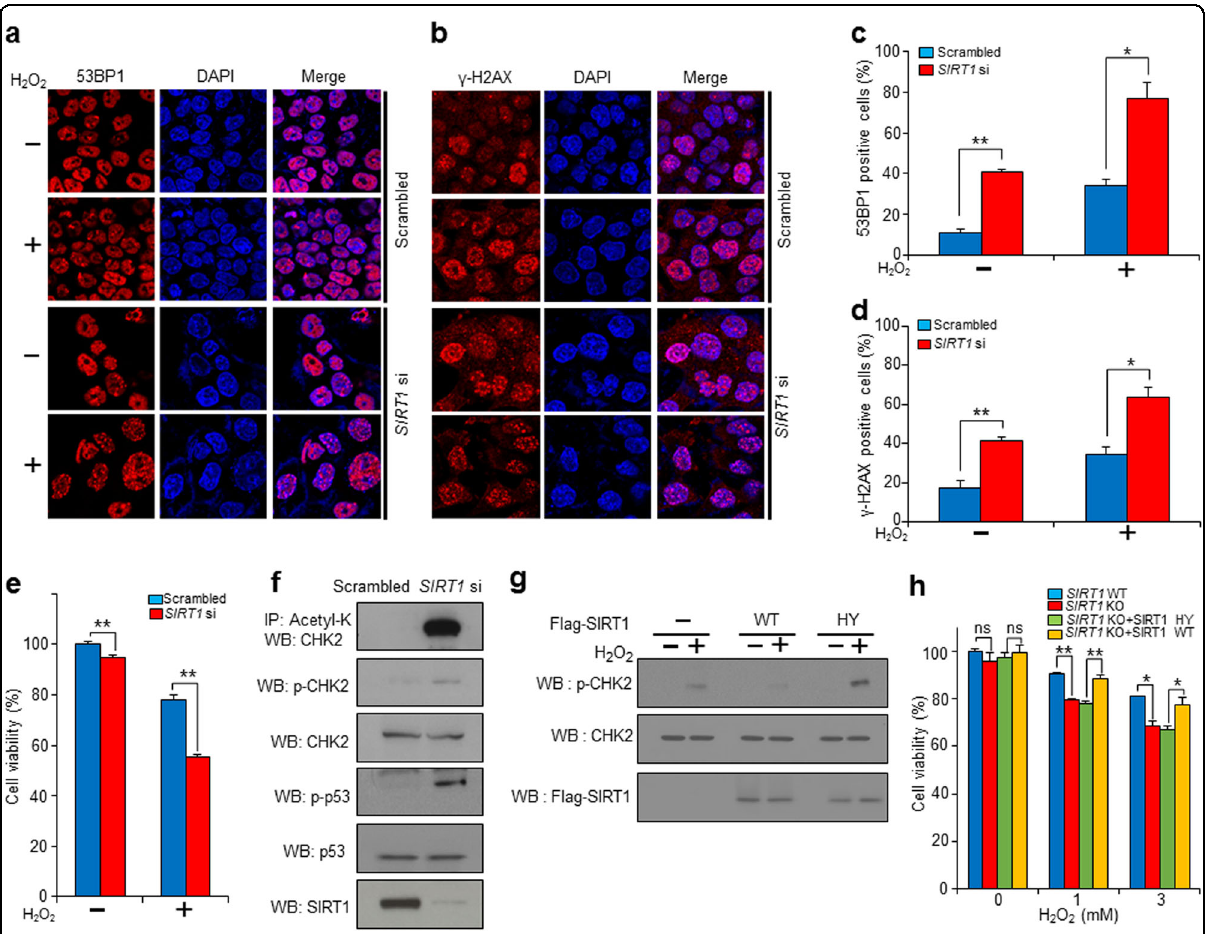
Fig. 3 Genetic inhibition of SIRT1 increases DDR-mediated cell death in oxidative stress conditions via upregulation of CHK2 activity. a , b Representative images of the levels of DNA damage in SIRT1 -de fi cient HeLa cells with/without oxidative stress. They were assessed by 53BP1 or phospho-H2AX staining. c , d SIRT1 de fi ciency potentiated DDR. Both 53BP1 and phospho-H2AX foci formation was increased in SIRT1 -de fi cient HeLa cells. Images were captured using a confocal laser scanning microscope from three independent experiments performed with duplicates per condition, counting approximately a minimum of 50 cells per condition (mean± SD, * P < 0.05, ** P < 0.01, Student ’ s t -test). e The viability of SIRT1 - de fi cient HeLa cells was further decreased compared with control (scrambled) cells, after treatment with H 2 O 2 for 1 h. f The levels of acetylated CHK2, phospho-CHK2 (p-CHK2) and phospho-p53 (p-p53) were increased in SIRT1 -knockdown HCT116 cells. g Inactive SIRT1 mutants (SIRT1 HY) potentiated CHK2 activity by increasing p-CHK2 levels in HCT116 cells. h SIRT1 de fi ciency (KO) increased cell death under oxidative stress conditions. The oxidative stress-mediated cell death in mouse embryonic fi broblasts was rescued by overexpression of SIRT1 WT but not by overexpression of SIRT1 HY. IP immunoprecipitation, WB western blot. Data represent the mean ± SD (* P < 0.05, ** P < 0.01, ns: not signi fi cant, Student ’ s t -test). Shown are